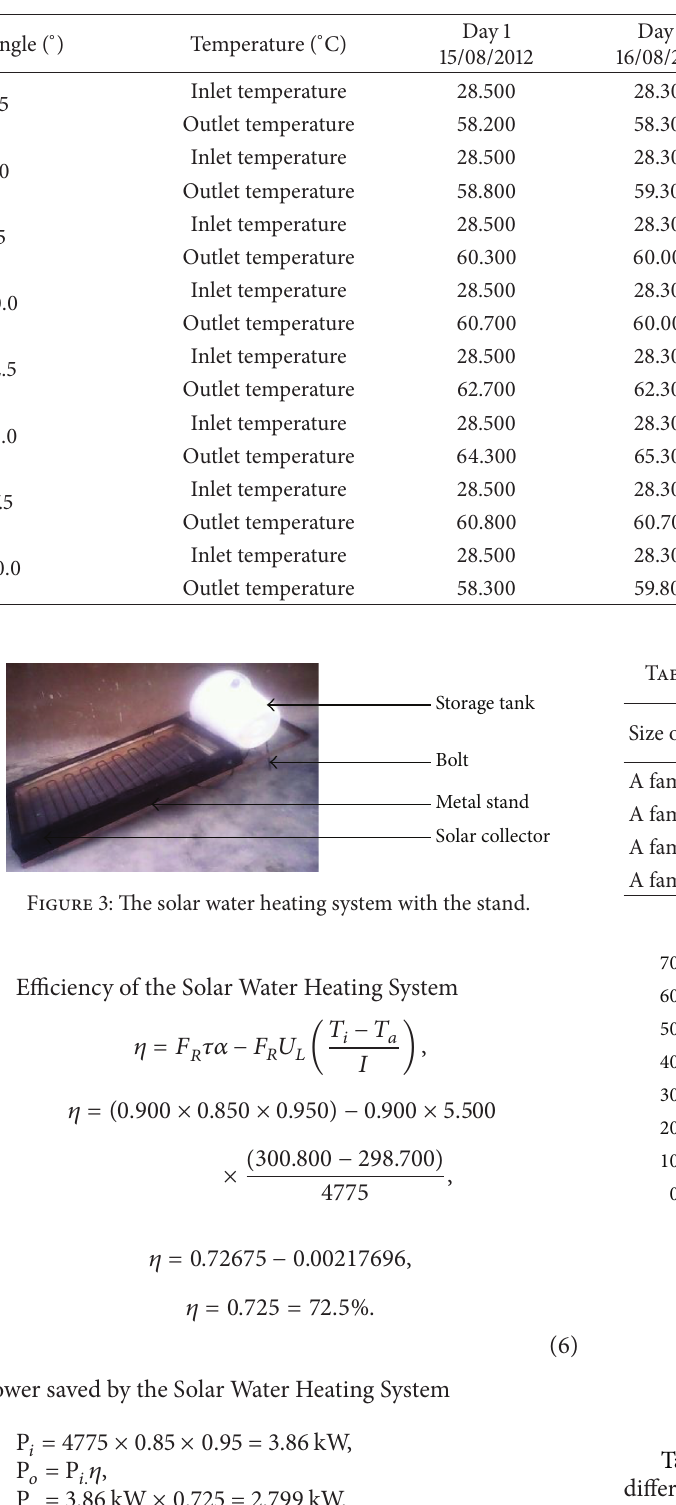
Table 9: Inlet and outlet temperature of water in the SWHS at different angles.